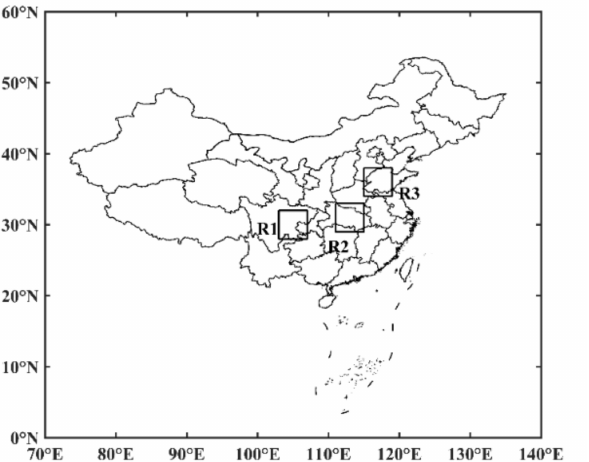
Figure 1. The regions of interest in this study (marked by black rectangles, R1: 28 ◦ ~32 ◦ N, 103 ◦ ~107 ◦ E;